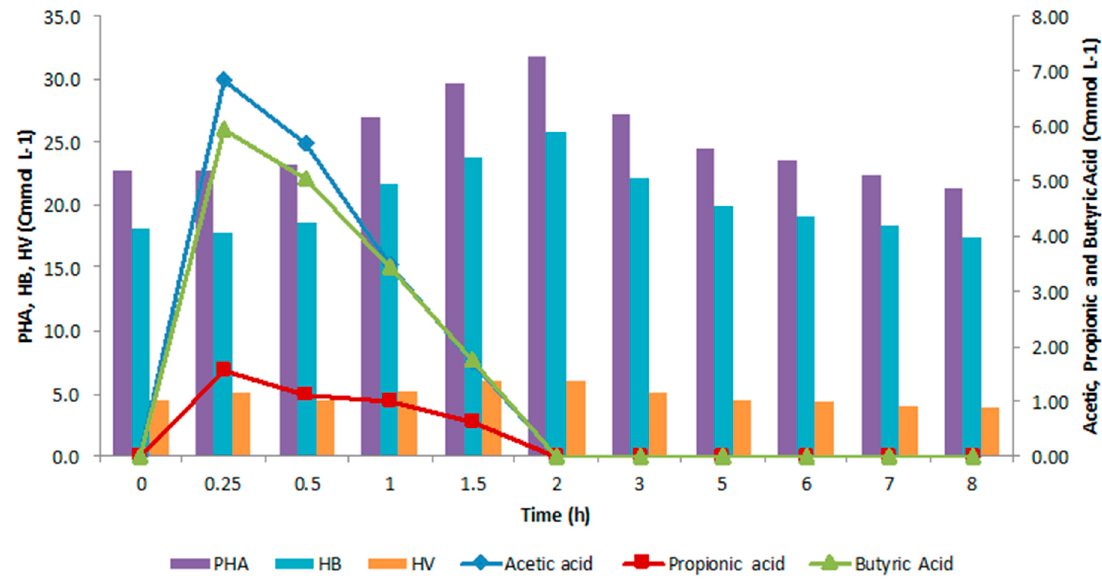
Figure 3. SBR representative cycle on the 66th day of operation: PHA, HB and HV content represented by purple, blue and orange bars, respectively, and acetic, propionic and butyric represented by blue, red and green lines.